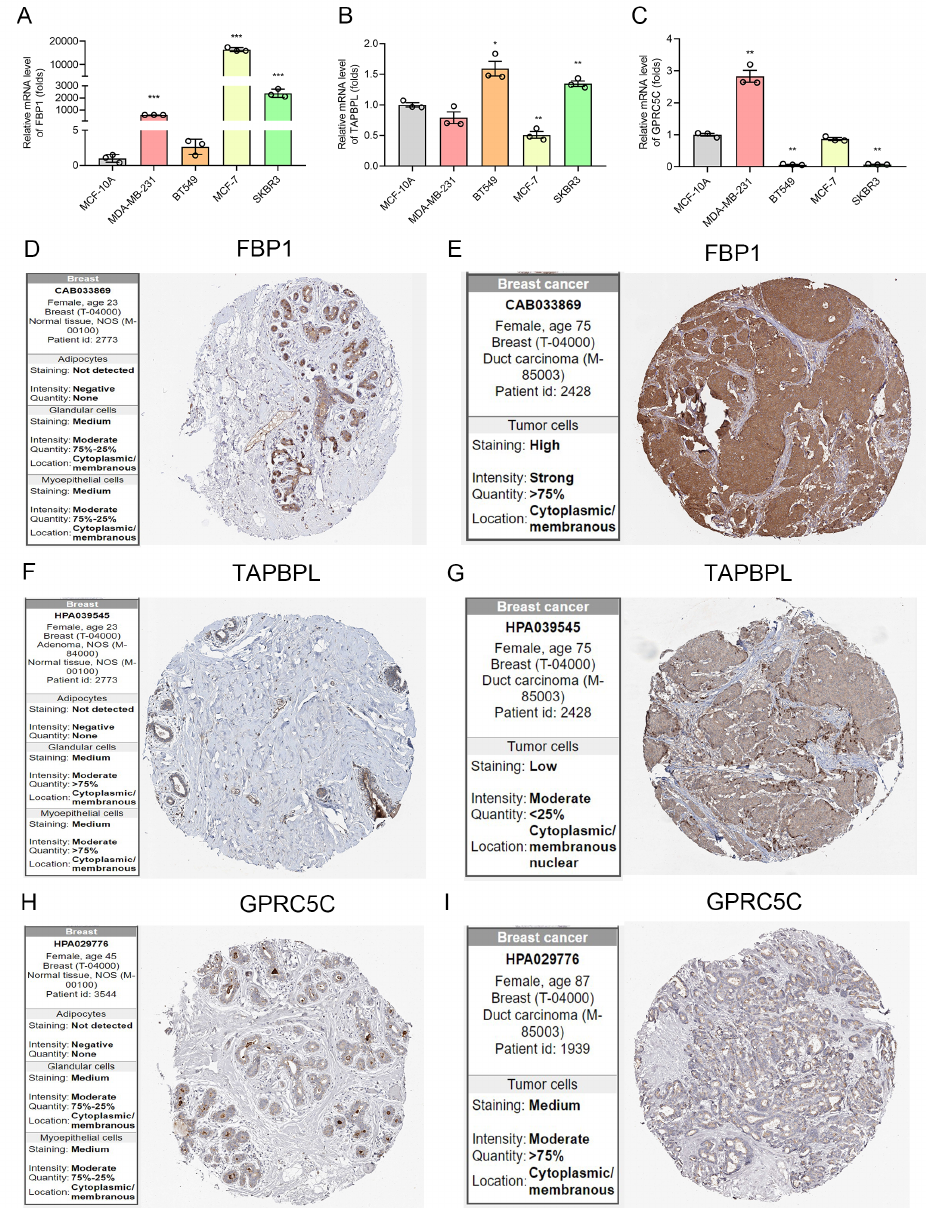
Figure 6. The mRNA and Protein level of IRGP in BC. ( A – C ) The mRNA levels of three immune- related genes in BC cell lines MDA-MB-231, BT549, MCF-7, and SKBR-3 cells compared with normal breast epithelial cells MCF-10A cells by qRT-PCR. * p < 0.05, ** p < 0.01, *** p < 0.001. ( D – I ) Represen- tative immunohistochemistry (IHC) staining of FBP1, TAPBPL, and GPRC5C in breast carcinoma and normal breast